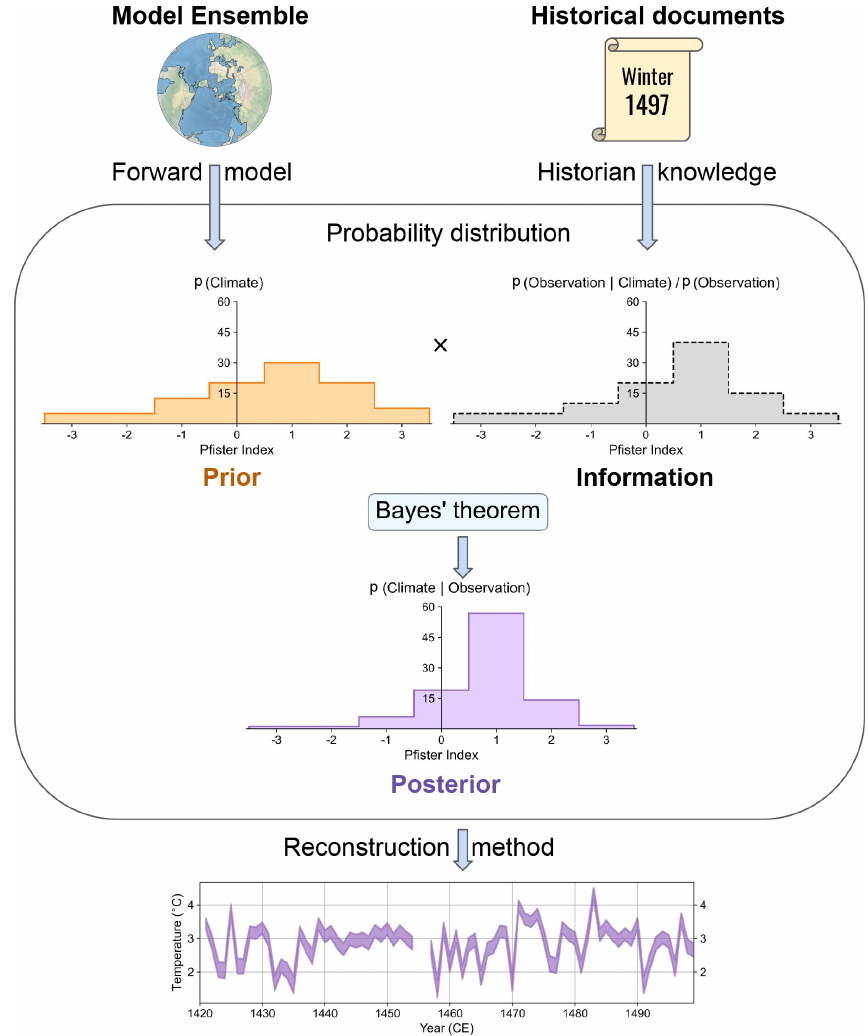
Figure 2. Methodology followed to assimilate historical documents into seasonal temperature and precipitation reconstructions of the Bur- gundian Low Countries during the 15th century. Outside the rounded square are the inputs (top) and output (bottom) of the climate recon- struction. All inputs are converted into probability distributions of Pfister indices from which posterior probability distributions are obtained using Bayes’ theorem.